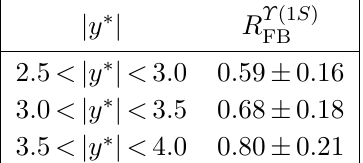
, as a function of j y (cid:3) j integrated over p T in the FB